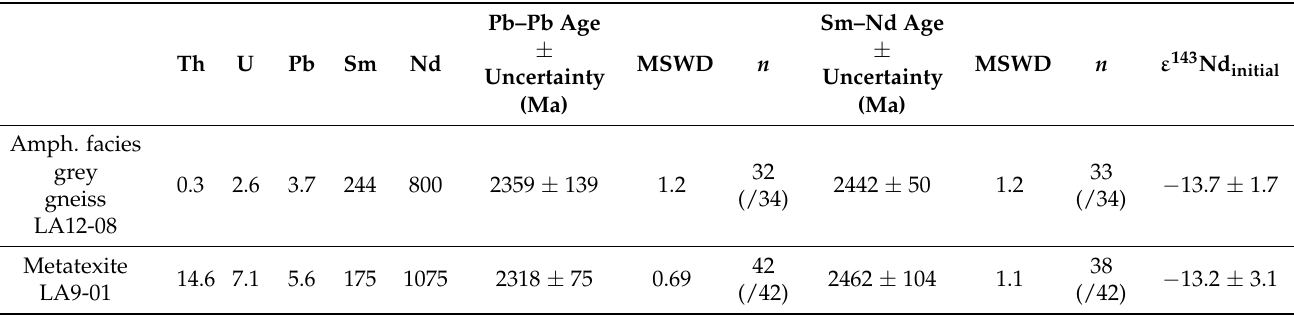
Table 1. Summary of the apatite U–Pb/Sm–Nd LASS analyses conducted in this study. Elemental contents are reported in part per million and were measured before LASS analyses ( n = 5 for each apatite population). Uncertainty is reported at 95% confidence level. Initial epsilon ( ε ) deviations were calculated following the Model-1 algorithm of [57] and include uncertainty in apparent age, CHUR model and decay constant. Corresponding Pb–Pb and Sm–Nd isochron diagrams are displayed in Figure